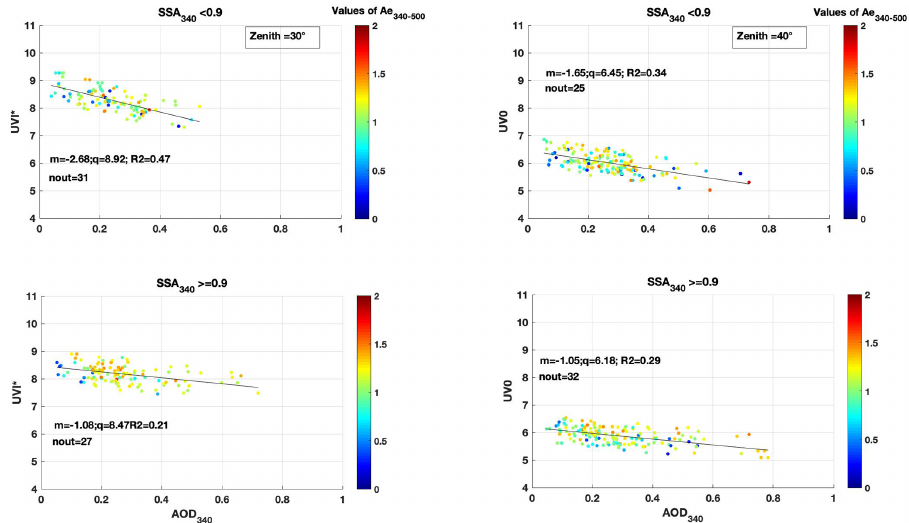
Figure 8. Scatterplot of UVI ∗ vs. AOD 340 for two groups of SSA 340 values and two solar zenith angles. The color scale refers to the values of Ang. Note: nout is the number of rejected outliers, m is the slope, and q is the intercept